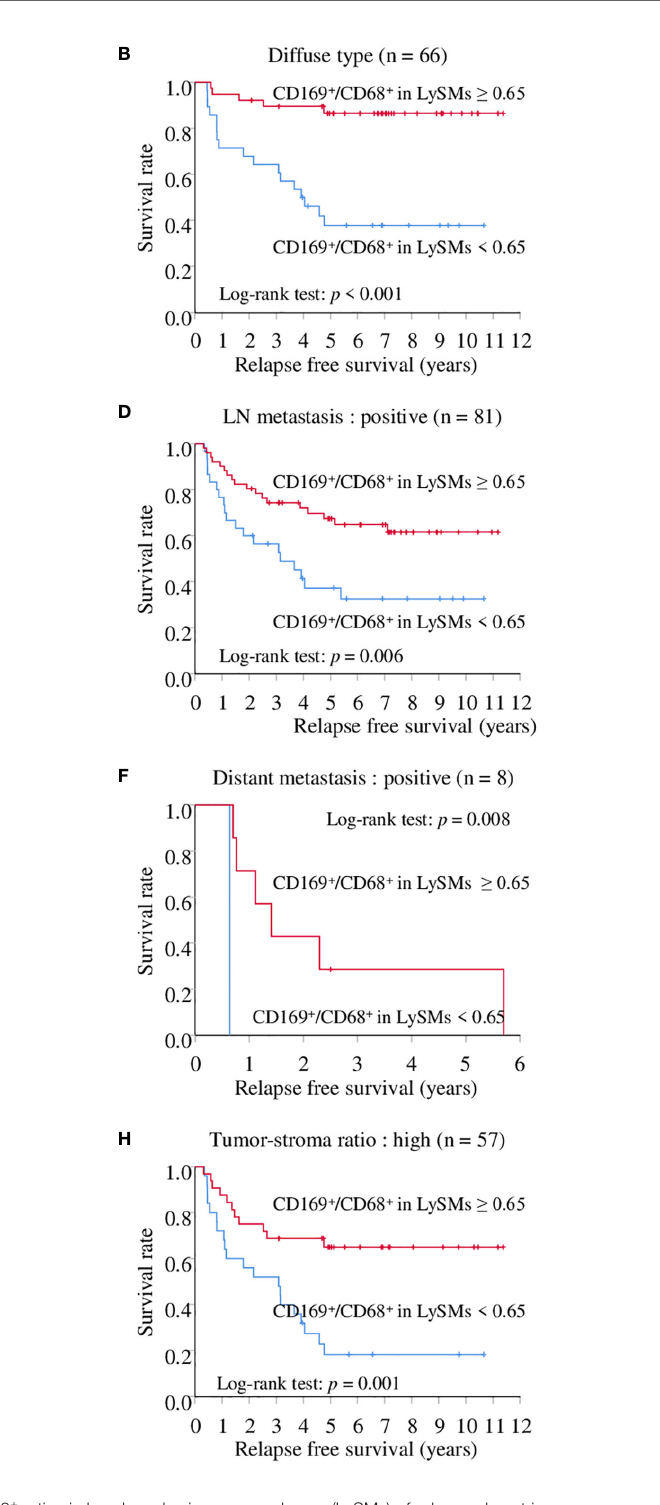
FIGURE 6 | Kaplan-Meier relapse free survival (RFS) curves of CD169 + /CD68 + ratios in lymph node sinus macrophages (LySMs) of advanced gastric cancer patients with various tumor subtypes: intestinal type (A) and diffuse type (B) ; lymph node (LN) metastasis negative (C) and positive (D) ; distant metastasis negative (E) and positive (F) , tumor-stroma ratio; low (G) and high (H)